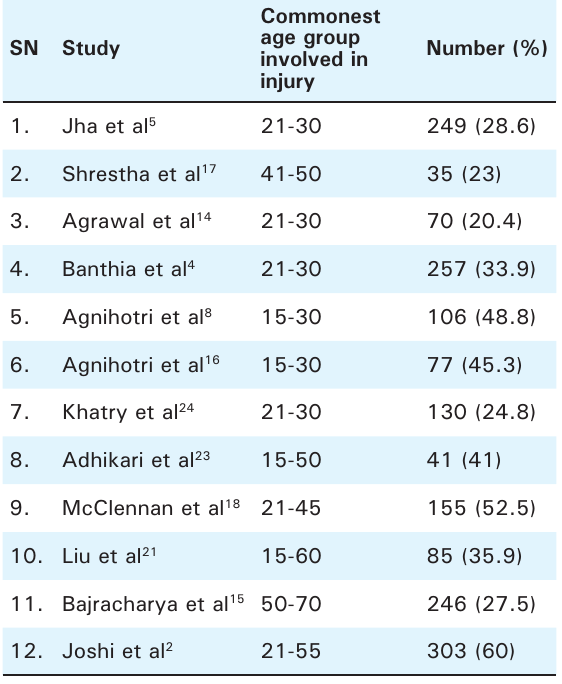
Table 3. Age distribution of the injury